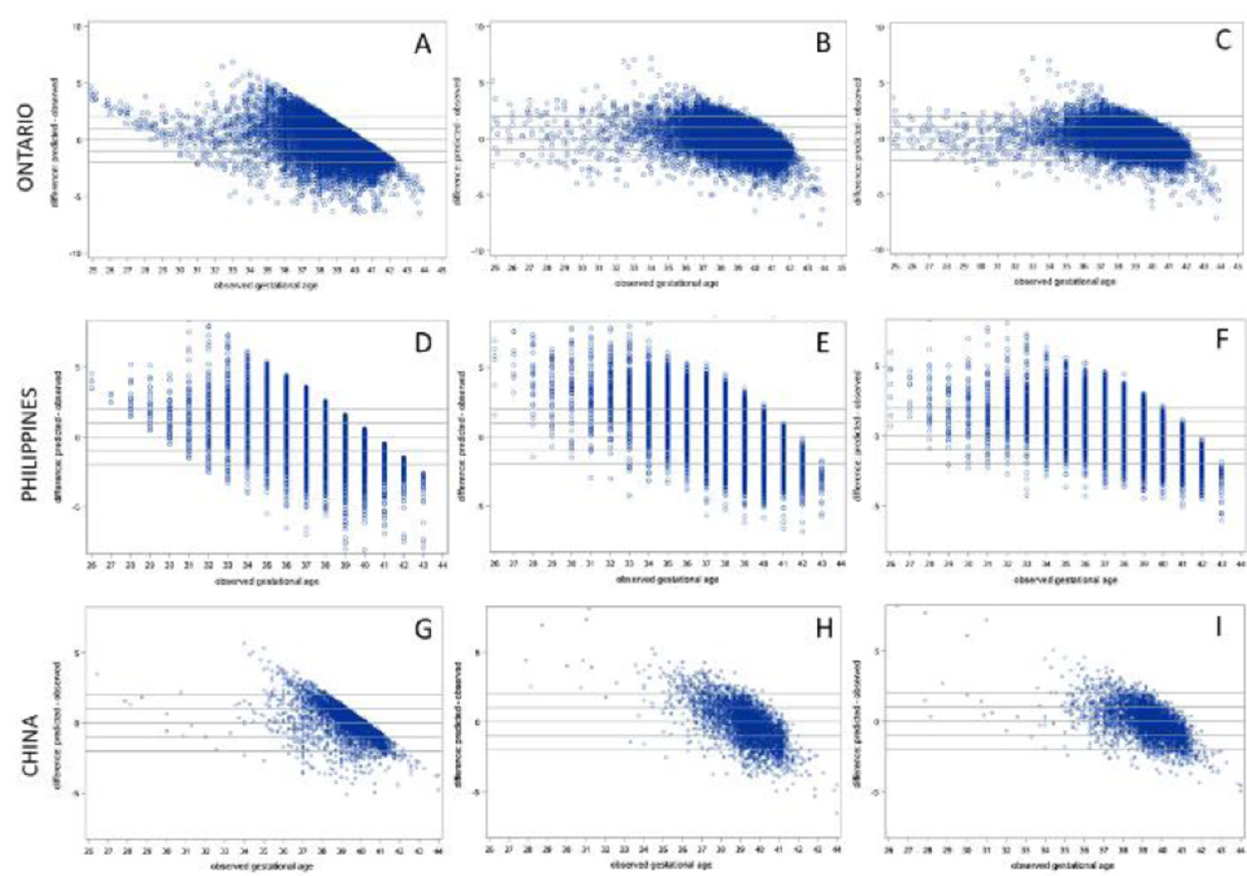
Figure 2. Residual plots of predicted – observed by ultrasound-assigned gestational age. Models applied to test cohort from Ontario: ( A ) Model 1 (sex + birthweight), ( B ) Model 2 (sex + analytes) ( C ) Model 3 (sex + birthweight +analytes). Models applied to cohort from the Philippines: ( D ) Model 1, ( E ) Model 2, and ( F ) Model 3. Models applied to cohort from China: ( G ) Model 1, ( H ) Model 2, and ( I ) Model